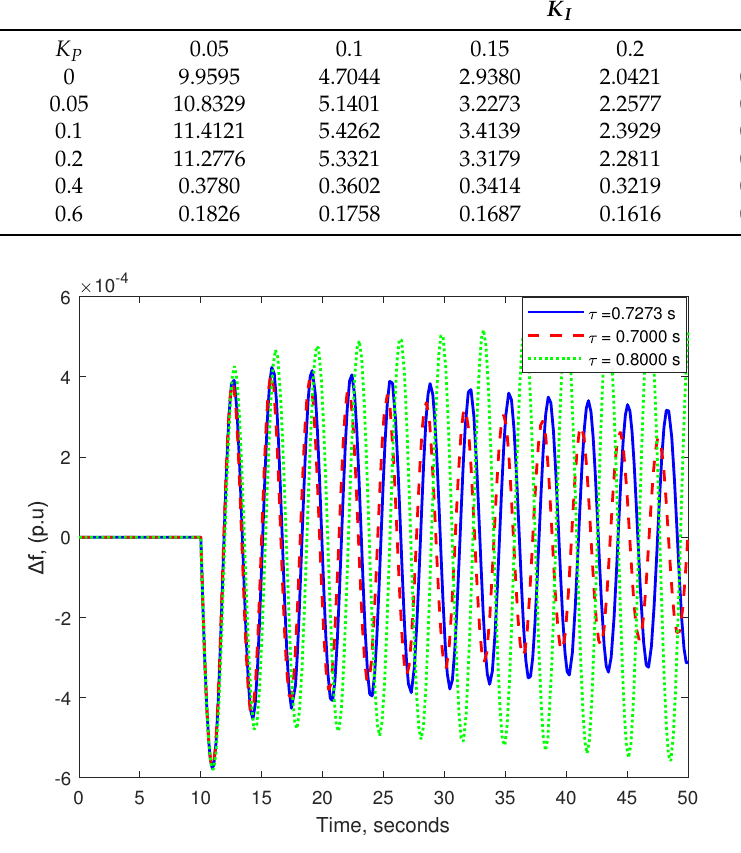
Figure 5. The frequency deviation with with G m = 2, K P = 0.4 and K I =